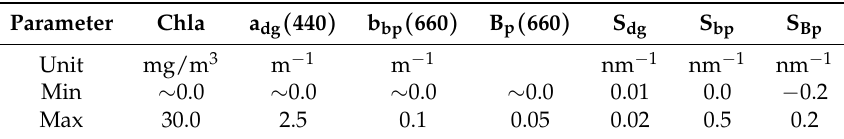
Table 1. Minimum and maximum values of parameters in the bio-optical models mentioned in Equation (1). Parameter Chla a dg ( 440 ) b bp ( 660 ) B p ( 660 ) S dg S bp S Bp Unit mg/m 3 m − 1 m − 1 nm − 1 nm − 1 nm − 1 Min ∼ 0.0 ∼ 0.0 ∼ 0.0 ∼ 0.0 0.01 0.0 − 0.2 Max 30.0 2.5 0.1 0.05 0.02 0.5